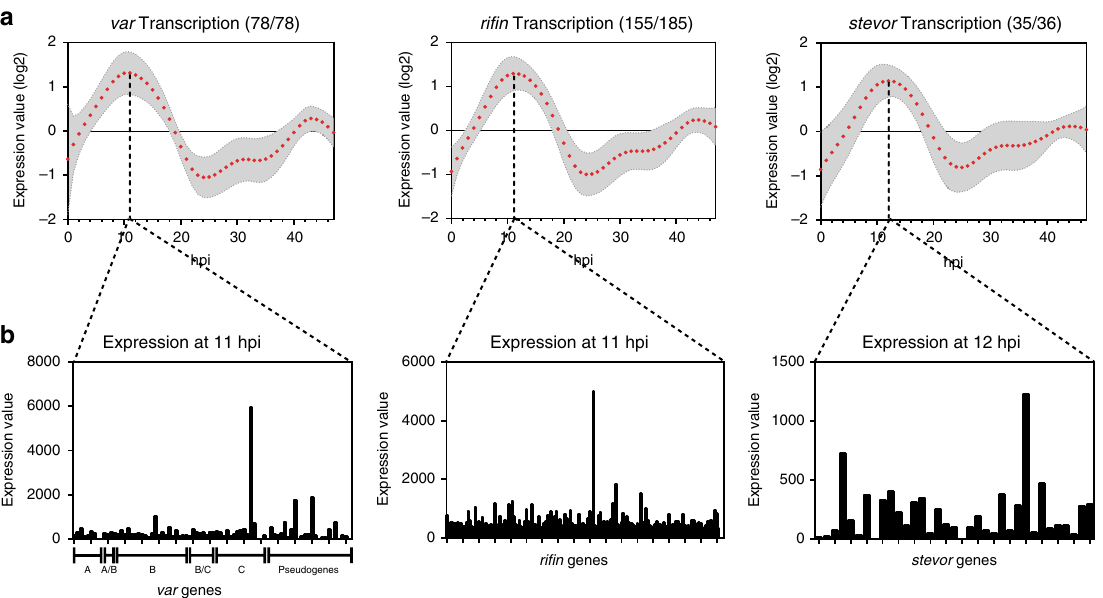
Fig. 4 Clonal expression of P. falciparum variant surface antigens. a Transcription of surface expressed gene families: vars (78/78), ri fi ns (155/185), and stevors (35/36) is displayed as the mean (log 2 expression value) and ±s.e.m. throughout the 48 h IDC. The hpi where peak transcription of each gene family is displayed as a dropline in each graph. b At the peak time of transcription, the expression value for each var (sub-groups and pseudogenes are labeled), ri fi n , and stevor genes